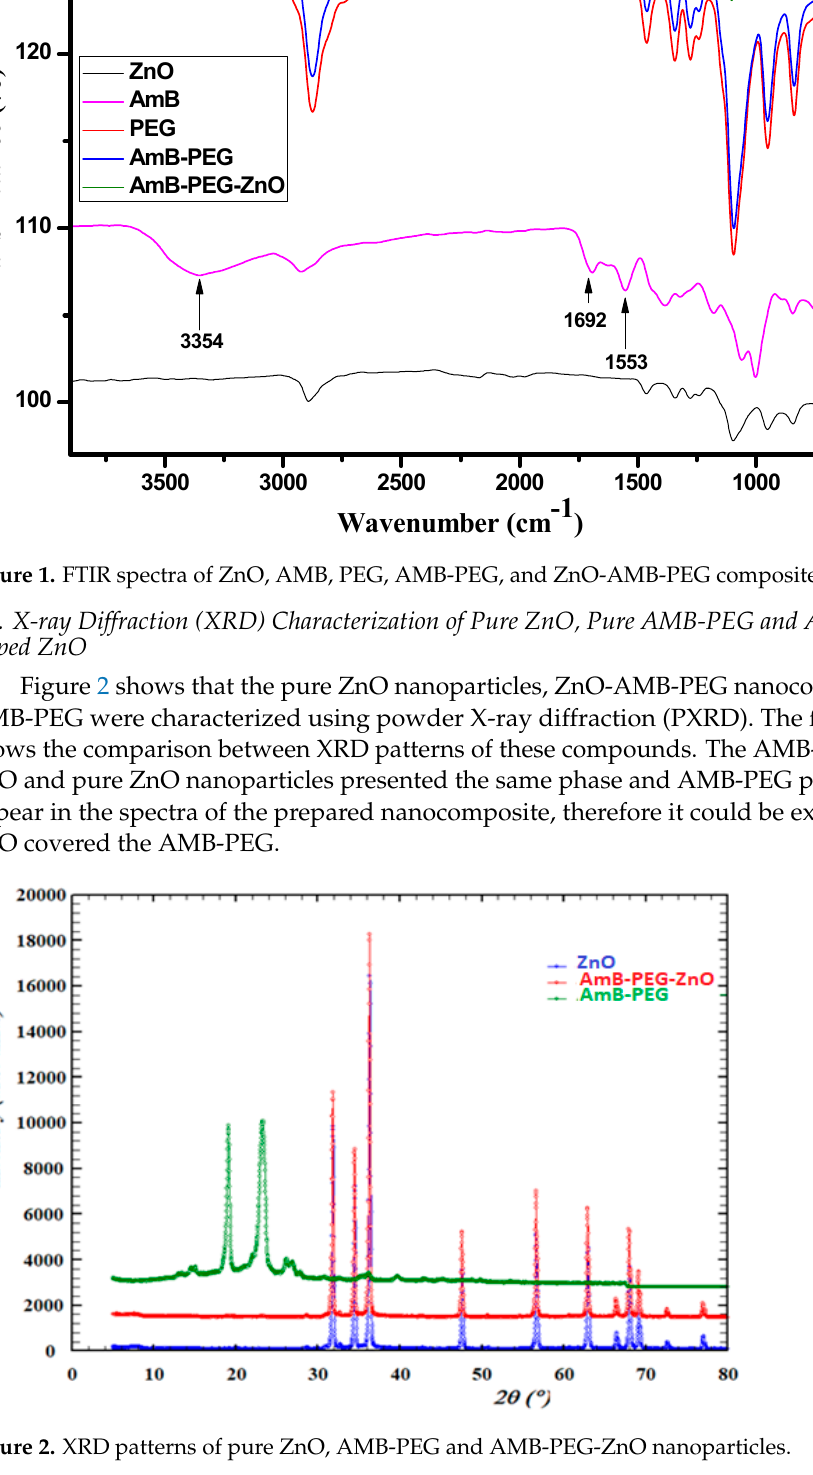
Figure 3. SEM image of AmB-PEG-ZnO sample.